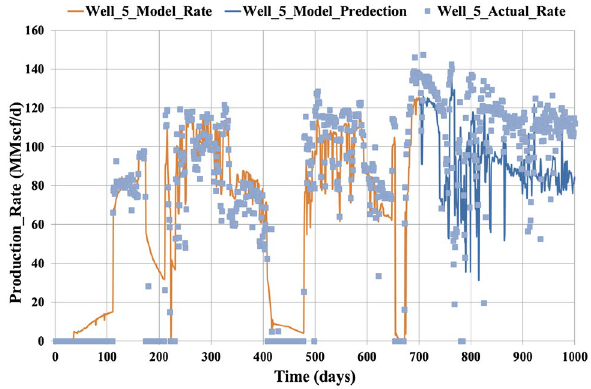
Fig. 8 Well 5 rate history match and prediction (case